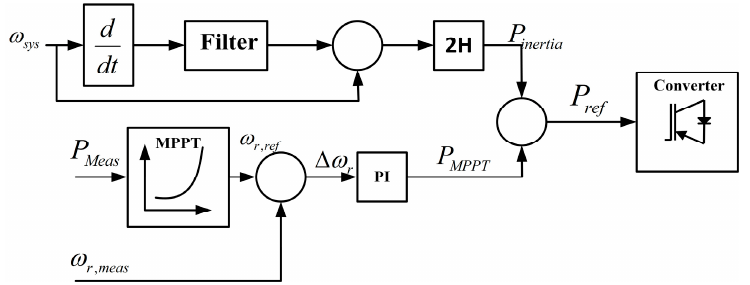
Figure 7. Hidden inertia emulation control [17].